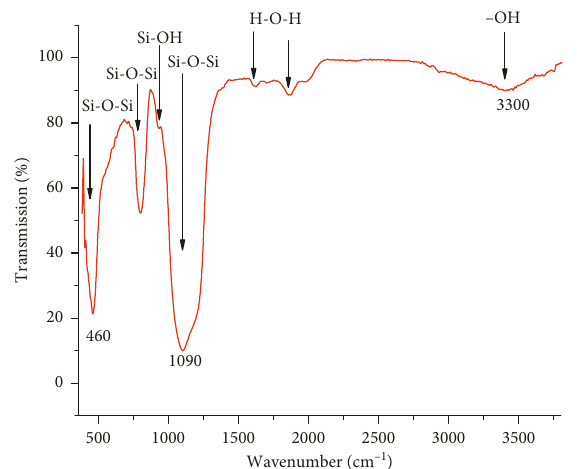
Figure 7: IR absorption spectrum of the Si nanocomposites.